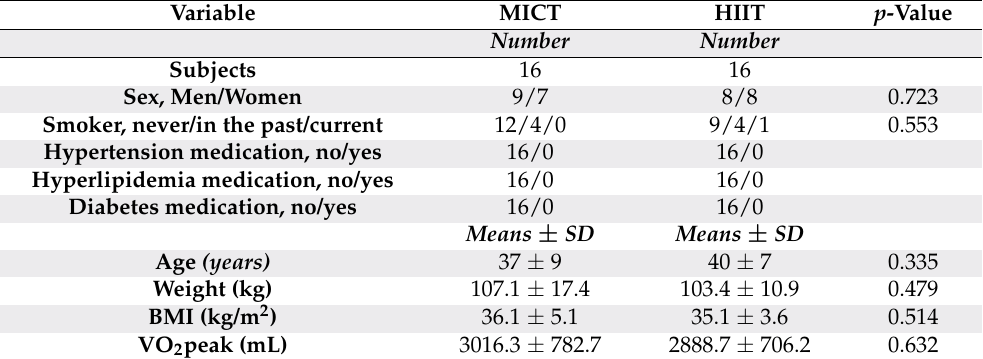
Table 1. Baseline parameters of the subjects recruited for MICT and